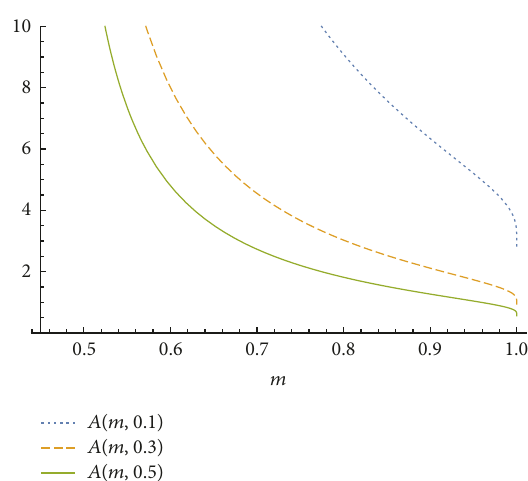
Figure 2: Velocity V (𝐴, 𝛼, 𝑚) (15) of solution (4) for different 𝐴 and 𝛼 . Figure 3: Amplitude 𝐴(𝑚, 𝛼) (39) of solution (4) as function of 𝑚 for 𝛼 = 0.1, 0.3, 0.5